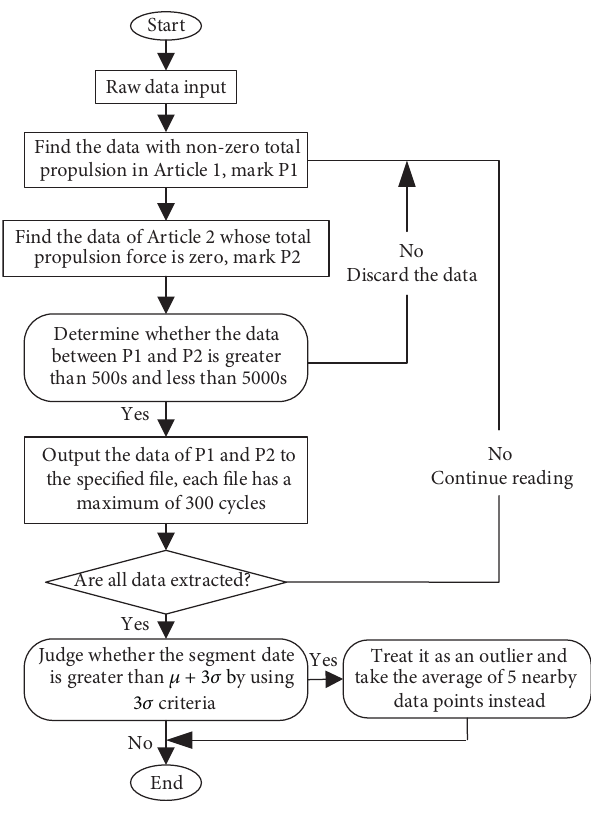
Figure 9: Data processing